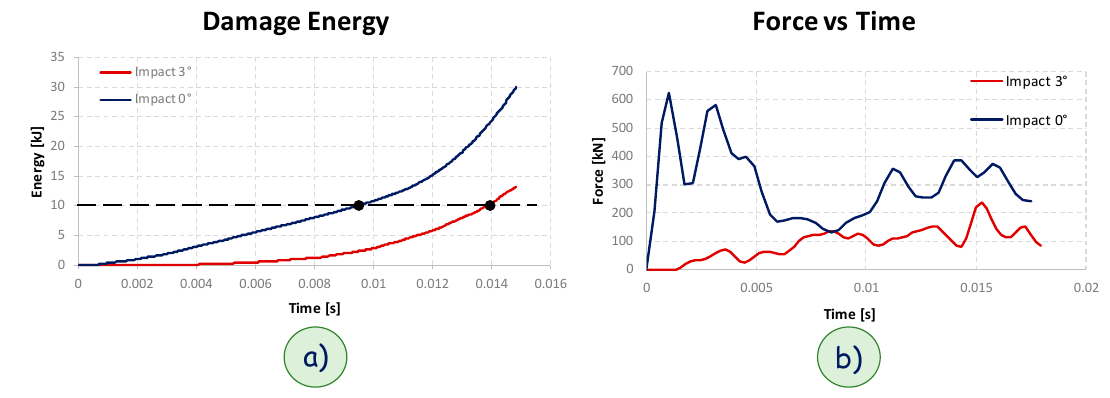
Figure 10. ( a ) Damage energy graph; ( b ) force vs. time graph.